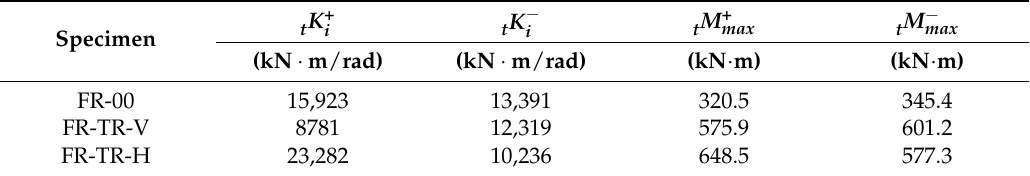
Table 3. Details of the